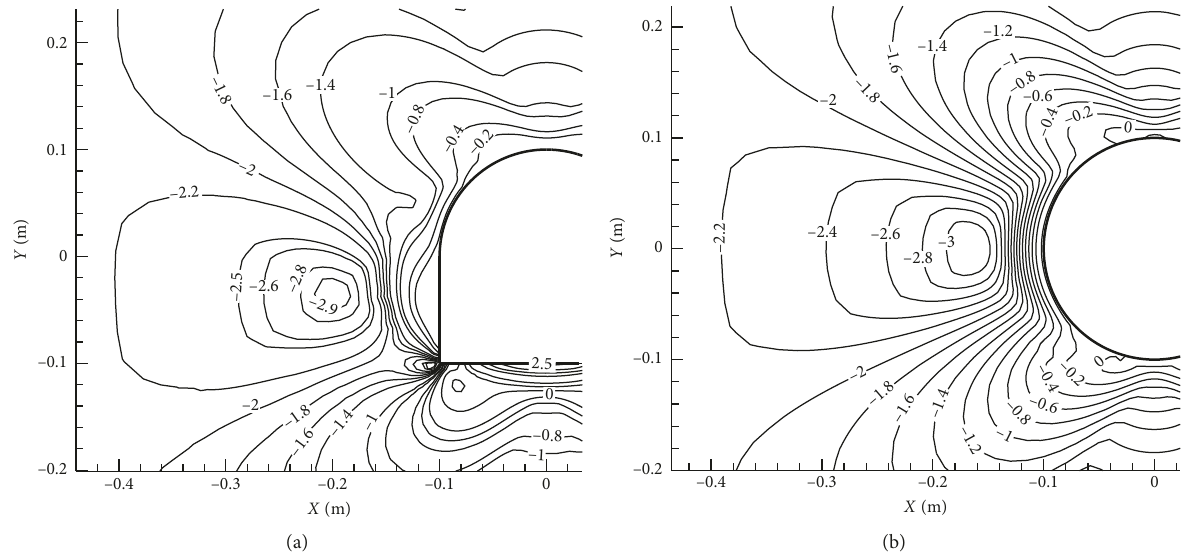
Figure 14: Numerical simulation results of the minimum principal stress in the rock surrounding the deep tunnel. (a) The horseshoe tunnel. (b) The circular